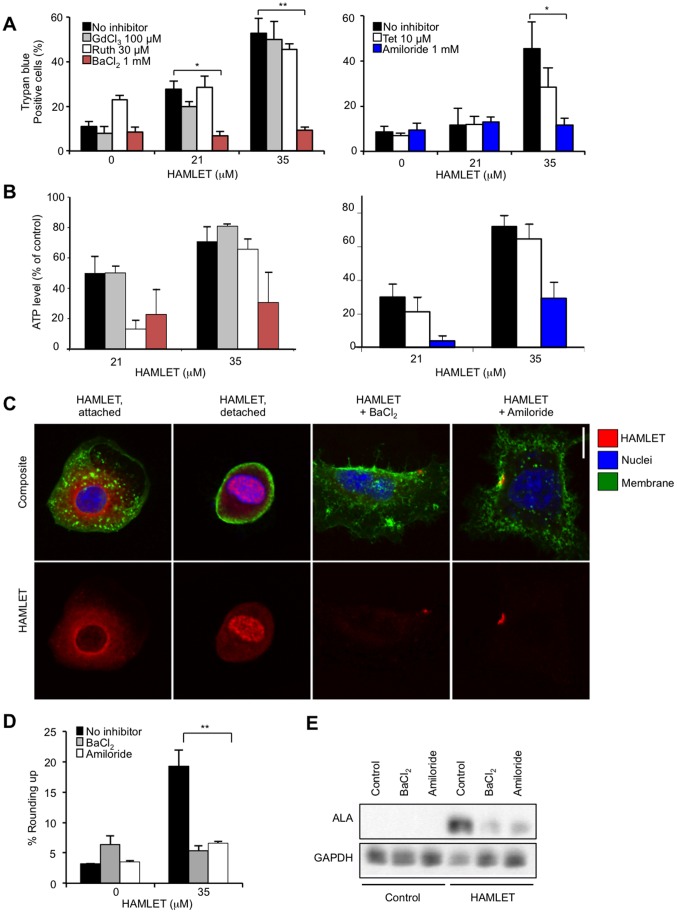
Ion channel inhibitors rescue carcinoma cells from death and block HAMLET uptake and morphologic change.(A, B) Viability of lung carcinoma cells after exposure to HAMLET (21 or 35 µM, 3 h), quantified by trypan blue exclusion and ATP levels. Amiloride or BaCl2 inhibited the tumoricidal effect of HAMLET but Ruthenium Red and tetrandrine showed no effect (means+SEMs, two to three experiments per condition). (C) Internalization of Alexa-568 fluor labeled HAMLET by tumor cells (35 µM, 1 hour), visualized by high magnification (x63) confocal microscopy. HAMLET was localized to peri-nuclear and nuclear regions in tumor cells. Amiloride or BaCl2 inhibited internalization, leaving HAMLET associated with the cell surface. HAMLET was labeled red (Alexa-568), nuclei blue (Draq5) and membranes were labeled green (WGA). Scale bar = 10 µM. (D) BaCl2 and amiloride prevented changes in carcinoma cells morphology in response to HAMLET (Mean of two images in one experiment+SEMs). Rounding up signifies the shift from an adherent, extended to a rounded morphology. (E) Western blot of cell lysates confirming the reduction in cell-associated HAMLET by amiloride and BaCl2 (35 µM, 1 hour, detected with anti-α-lactalbumin antibodies, ALA). GAPDH was used as a loading control.